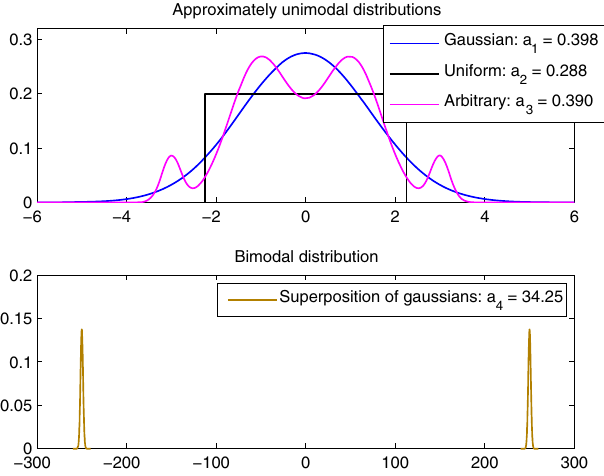
FIG. 2. Examples of approximately unimodal distributions (above) and bimodal distribution (below), for continuous dis- tributions in the limit ϵ → 0 . The bimodal distribution can violate ϵ Þ ∼ ð ϵ = σ Þ , simply because one can make the the estimate ξ p ð standard deviation arbitrarily large by placing the peaks further ϵ Þ apart without changing the actual value of ξ p ð